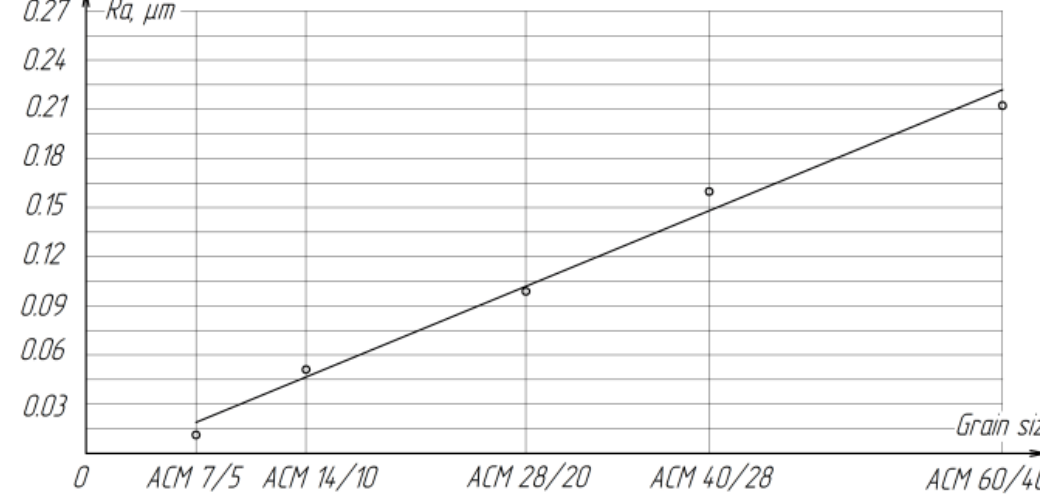
Figure 9. The effect of grain size on the roughness of the treated surface of ZrO 2 ceramics. Table 4. The effect of the amount of diamond paste on the productivity and roughness of the treated surface.